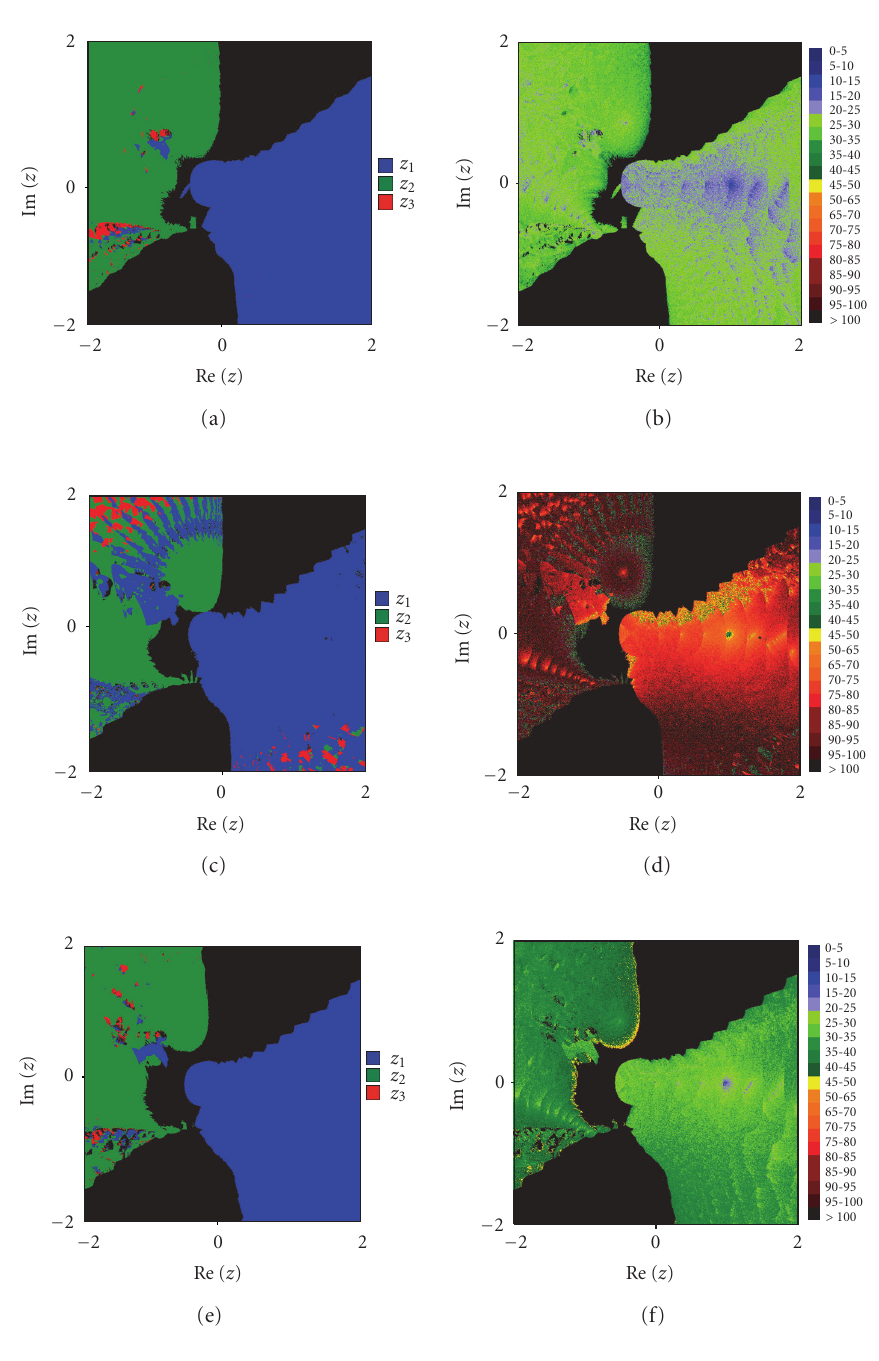
Figure 4.10. Basin of attraction for z 3 − 1 = 0 using GCG method and W-L.S. with: (a)–(b) β = 0 . 360+ i · 0 . 840, (c)–(d) β = 0 . 716+ i · 0 . 5724, (e)–(f) β = 0 . 456+ i · 0 .